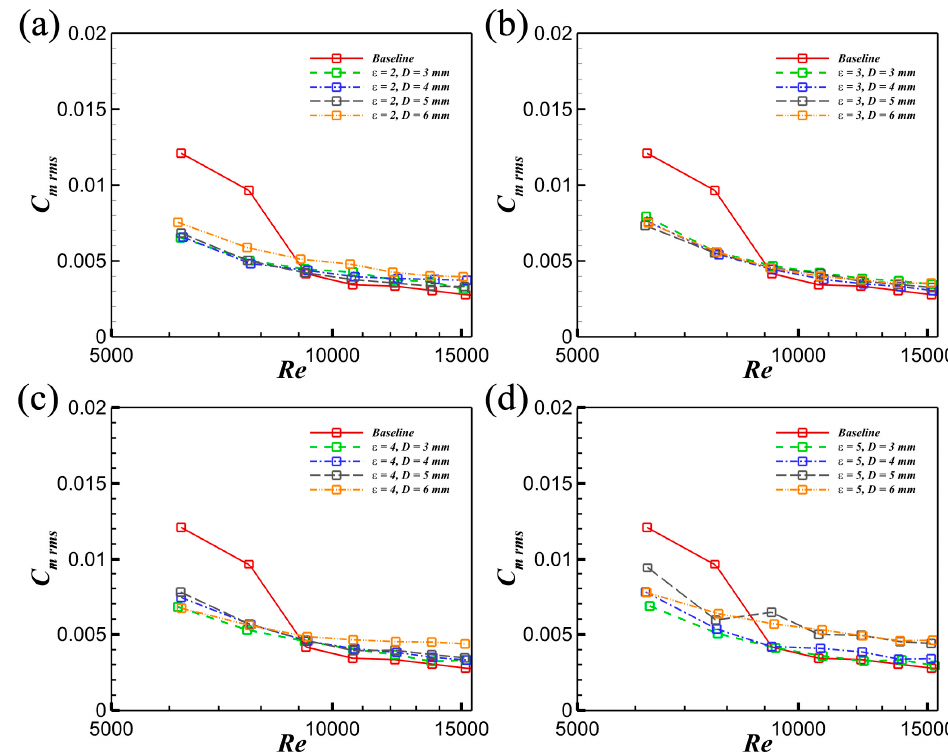
Figure 19. ( a – d ) The relationship between the time-averaged moment force coefficient and the Reyn- olds number at different spacing ratios and cylinder diameters.